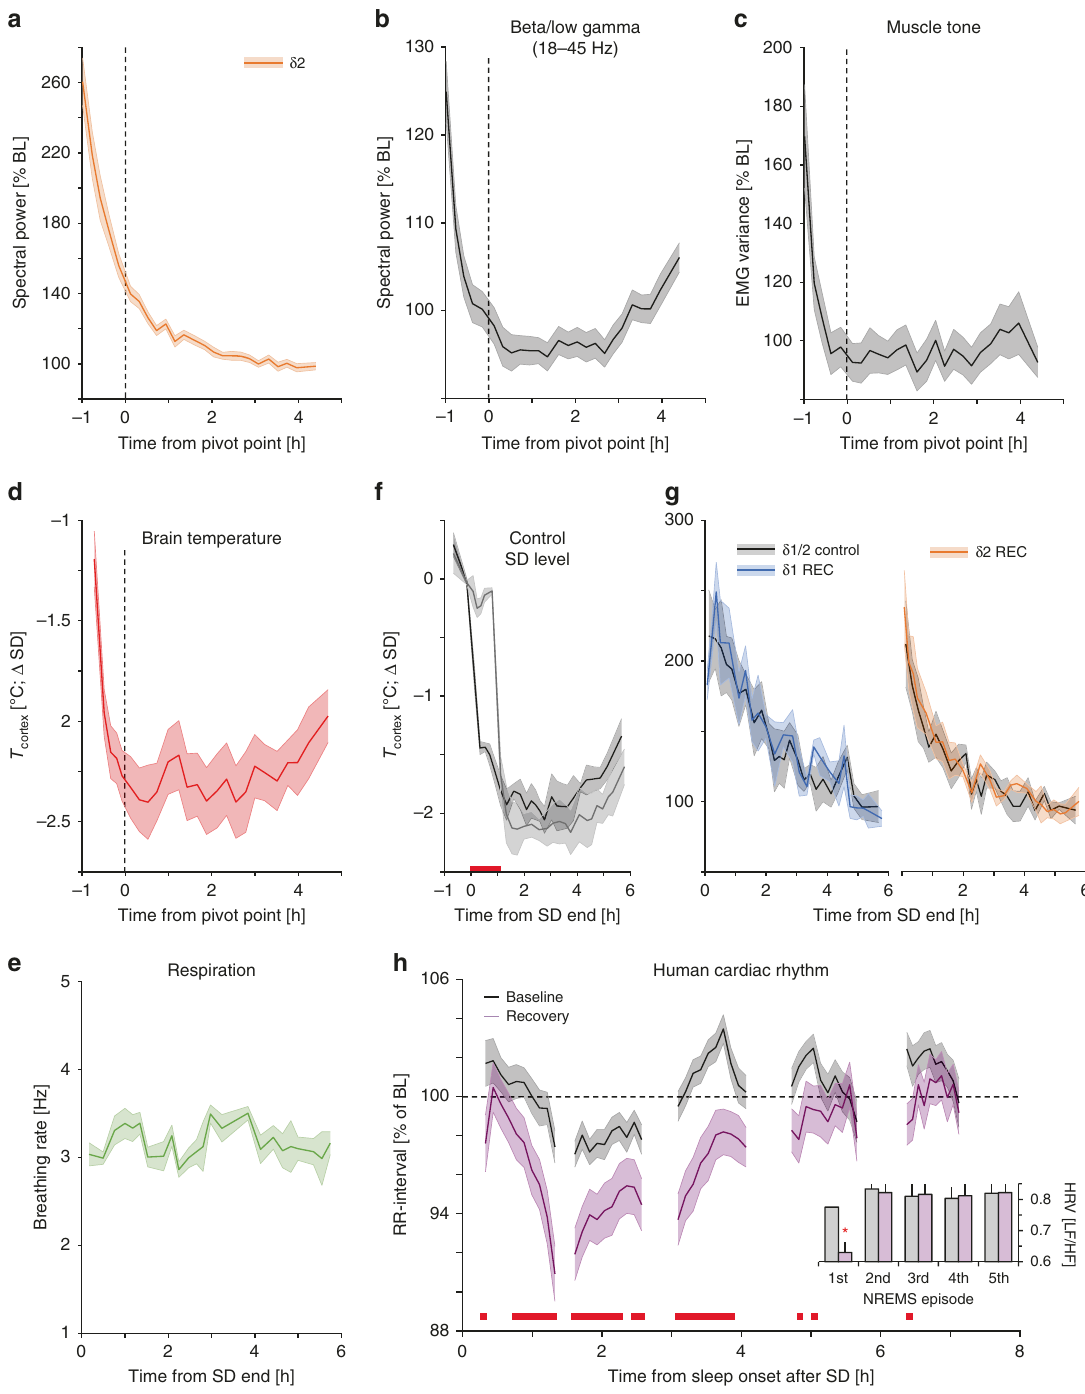
Fig. 7 δ 2-dynamics typify a physiologically different NREMS sub-state. a δ 2-power declines across the 1st 6 h of recovery as does b EEG power in higher frequencies (beta/low-gamma: 18 – 45 Hz), c muscle tone, and d brain temperature ( T cortex ), but not ( e ) respiratory rate. Of note, beta/low-gamma power was greater following SD than at any point during baseline (Supplementary Fig. 6f). f , g Experimentally maintaining T cortex at sleep deprivation (SD) levels during the fi rst hour of recovery (REC) in a subset of mice ( n = 4), did not alter δ 1- or δ 2-dynamics. h Human cardiac rhythm (measured as RR-intervals expressed as percentage of mean baseline (BL) RR-interval (1.07 ± 0.02 s)) differed early in NREMS during recovery compared to baseline, as well as subsequent episodes (two-way rANOVA factors condition x time-course: F 49,3822 = 1.8, p = 0.001), which was also re fl ected in heart rate variability (insert: HRV quanti fi ed as the LF/HF-ratio (see Methods); two-way rANOVA factors condition × time-course: F 4,312 = 6.7, p = 0.008]. All values are mean ± s.e.m. and post-hoc signi fi cance ( p < 0.05) is denoted with red lines (or asterisk; H-insert). Vertical dashed lines in a – e represent average of